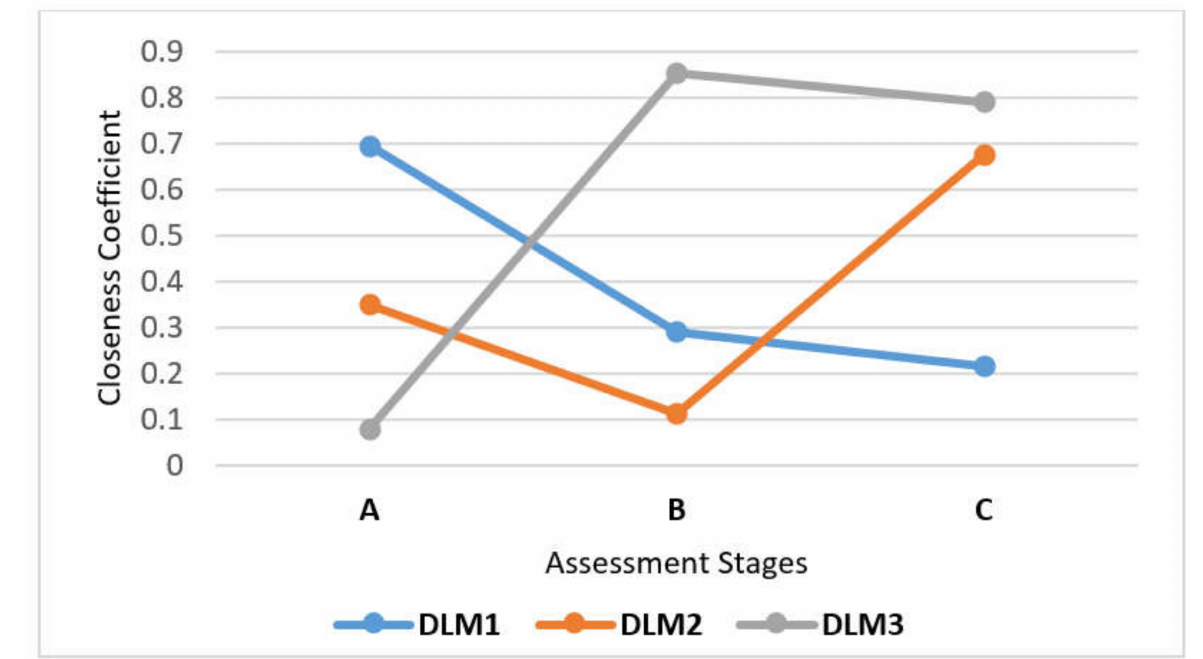
Figure 2. The study results of quality assessment of distance learning modules—DLM1, Research methodology and statistical analysis; DLM2, Social Statistics; and DLM3, Political Science Research Methodology—according to three expert groups presented by the closeness coefficient of each distance learning module after three assessment stages: A, course structure; B, information tools usage; C, military students’